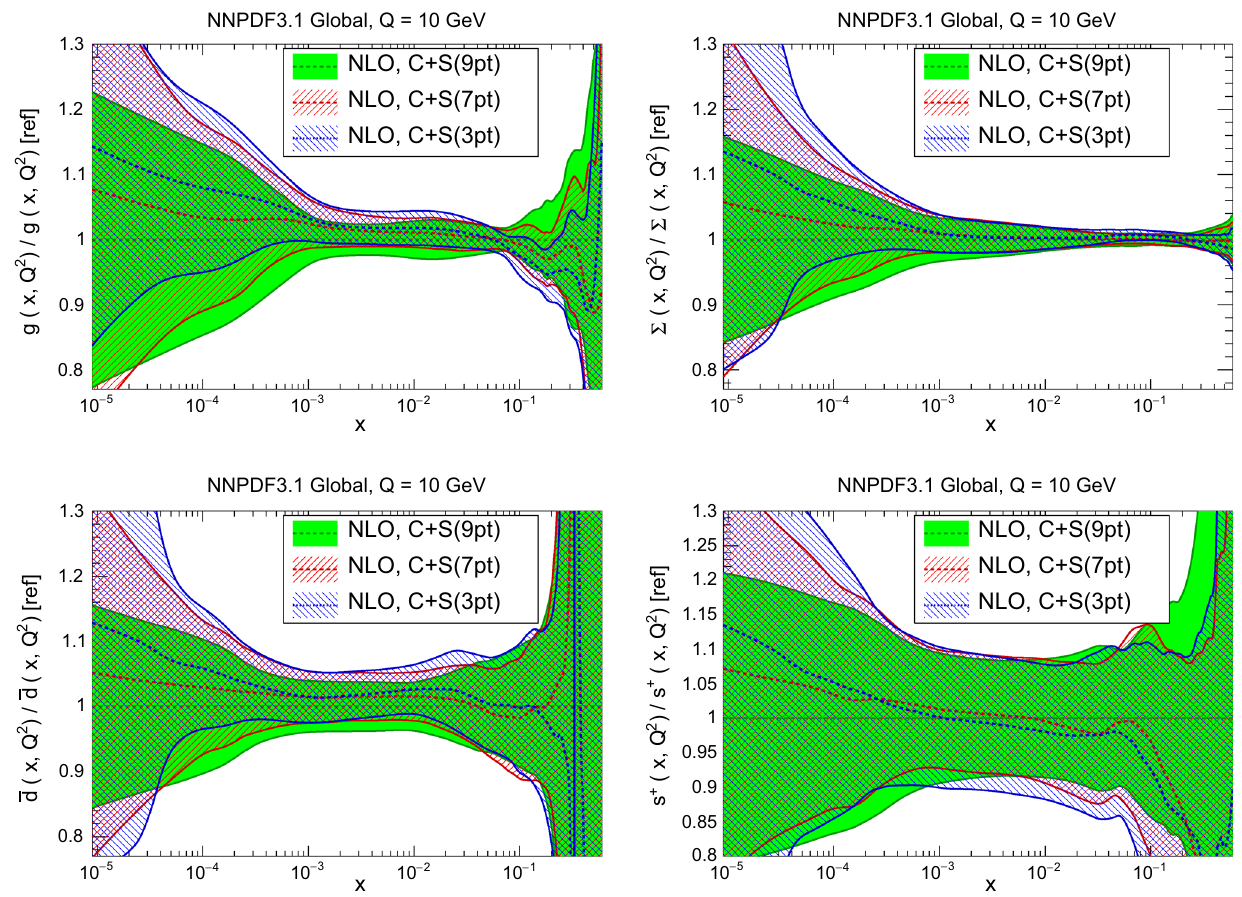
Fig. 18 Same as Fig. 16 now comparing the results of the NNPDF3.1 global fits with the theory covariance matrix constructed accordingly to the 3-, 7-, and 9-point prescriptions, normalized to the central value of the latter